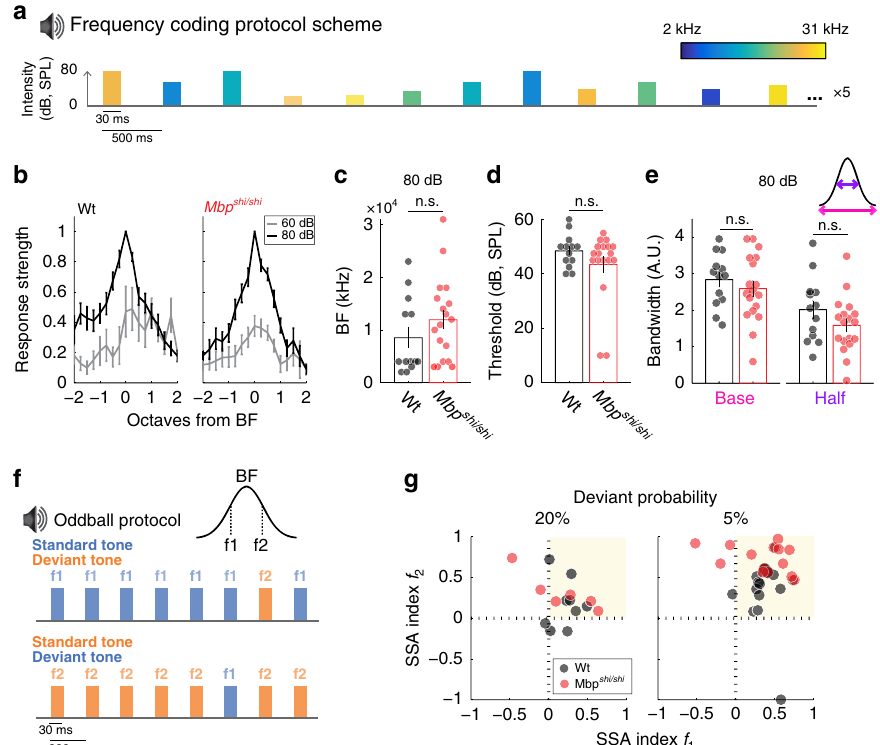
Fig. 6 Frequency responses, tuning, and discrimination are not affected with dysmyelination in the ACx. a Schematic of the tone-sweep protocol used to test tuning. Twenty-four 30-ms-long, pure tones (2 – 31 kHz) were played at different intensities in ten repetitions (Rep.) of each frequency-intensity combination in random order. b – e Basic tuning properties are not affected with dysmyelination. Wt: n = 13 recordings, ten mice. Mbp shi/shi : n = 18 recordings, 15 mice. b Normalized tuning curves for Wt (left) and Mbp shi/shi mice showing selectivity in octaves from best frequency (BF) at 60 (gray) and 80 dB (black). c Recordings from comparable rostrocaudal locations yielded comparable BFs at 80 dB (two-sided Wilcoxon rank-sum test, P = 0.25, t = 1.839) indicating normal tonotopy. d Auditory cortical thresholds were comparable between groups (two-sided Wilcoxon rank-sum test, P = 0.51, t = − 1.638). e Tuning bandwidth was comparable between groups (two-sided Wilcoxon rank-sum test, P = 0.56, t = − 1.148, and P = 0.21, t = − 2.363 for base and half-bandwidth, respectively). f Schematic of the oddball protocol used to test stimulus-speci fi c adaptation. Two tones differing in a Δ f of 10% were presented (rate 3 Hz) with different probability. The standard tone was presented with high probability (80 or 95% of trials) and the deviant tone with low probability (20 or 5%). g Stimulus-speci fi c adaptation indices (normalized difference between deviant and standard response) for the two tones were plotted against each other. For low deviant probabilities (Dp = 5%), indices were above 0.3, indicating that deviant responses were at least twice as large as standard. This effect diminished as the probability of the deviant sound increased. While no difference in SSA was observed between the groups